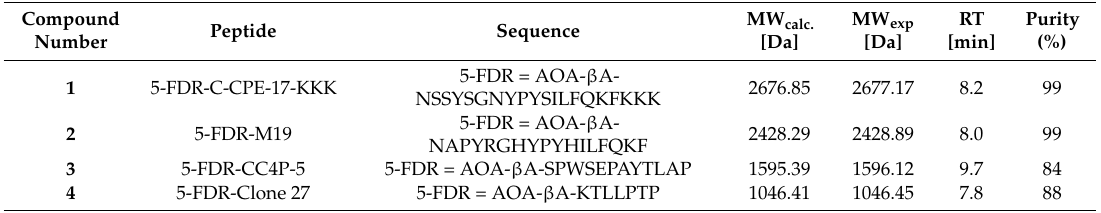
Table 1. Peptide codes, sequences, and analytical data of the peptide conjugates obtained after 5-FDR coupling. (5-FDR: 5-fluoro-5-deoxy- D -ribose; AOA: aminooxyacetic acid; β A: β -alanine; RT: retention time, for details, see experimental part).